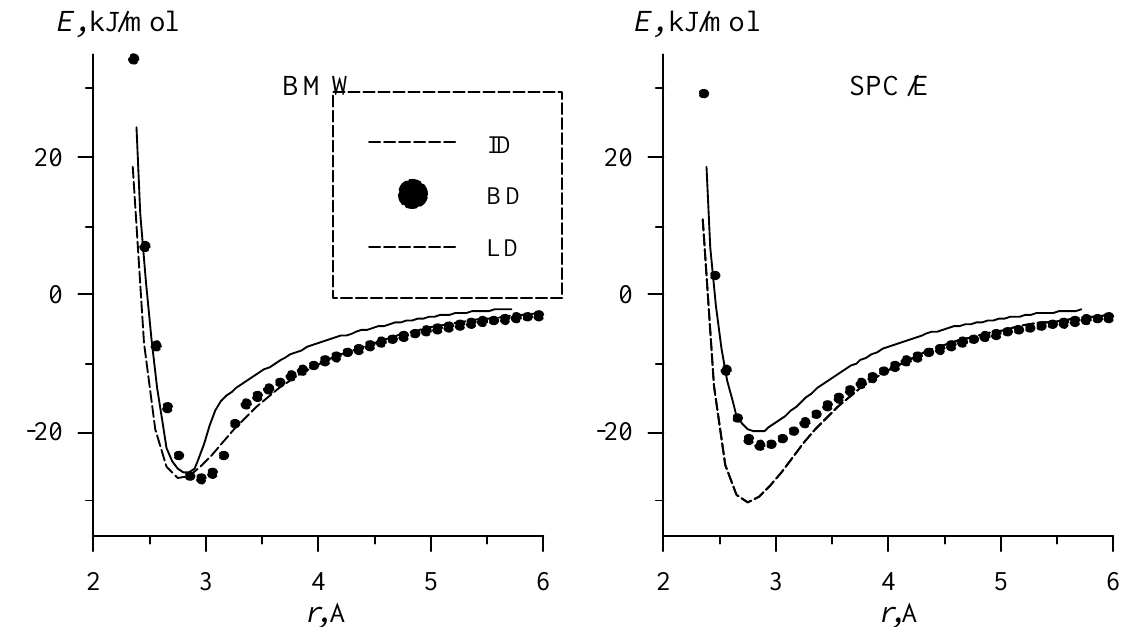
Figure 3. Energy dependences on distance for inverted, bifurcated, and linear